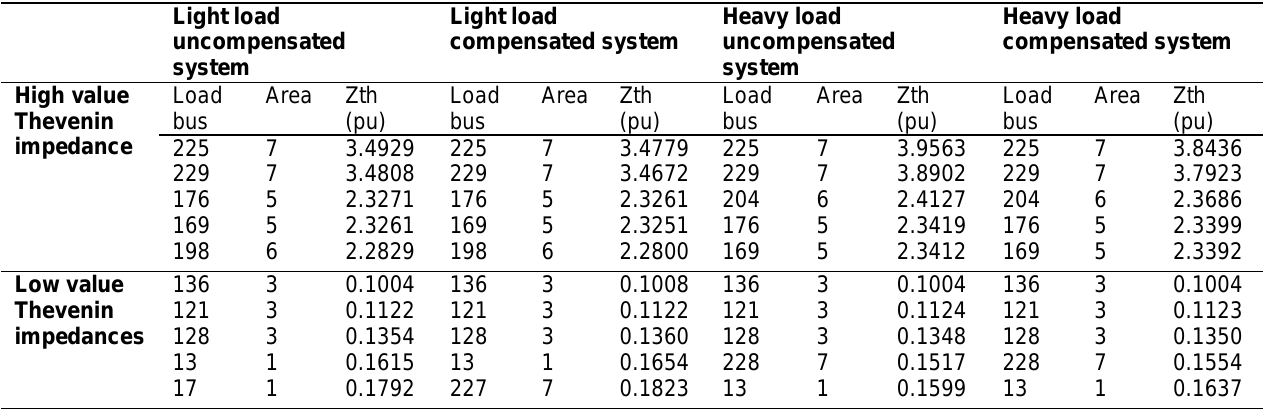
Table 2. High value and low value Thevenin